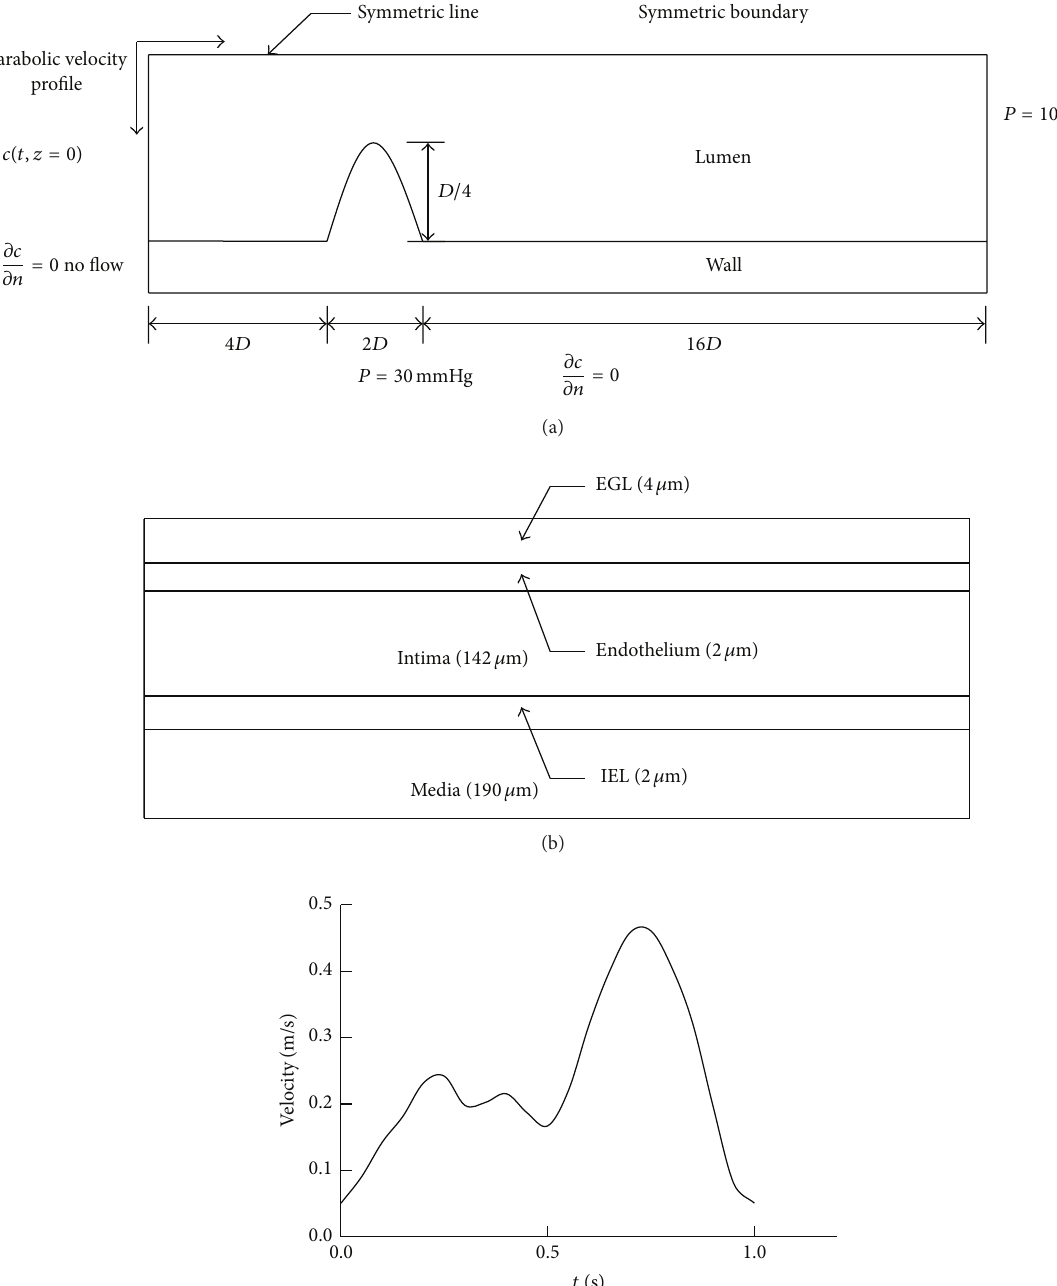
because it is hard to measure the parameters, the transport parameters are scarce. In the present study, most of the parameters were obtained from theoretical models. The calculation of the parameters is presented in Appendix. The parameters used are summarized in Table